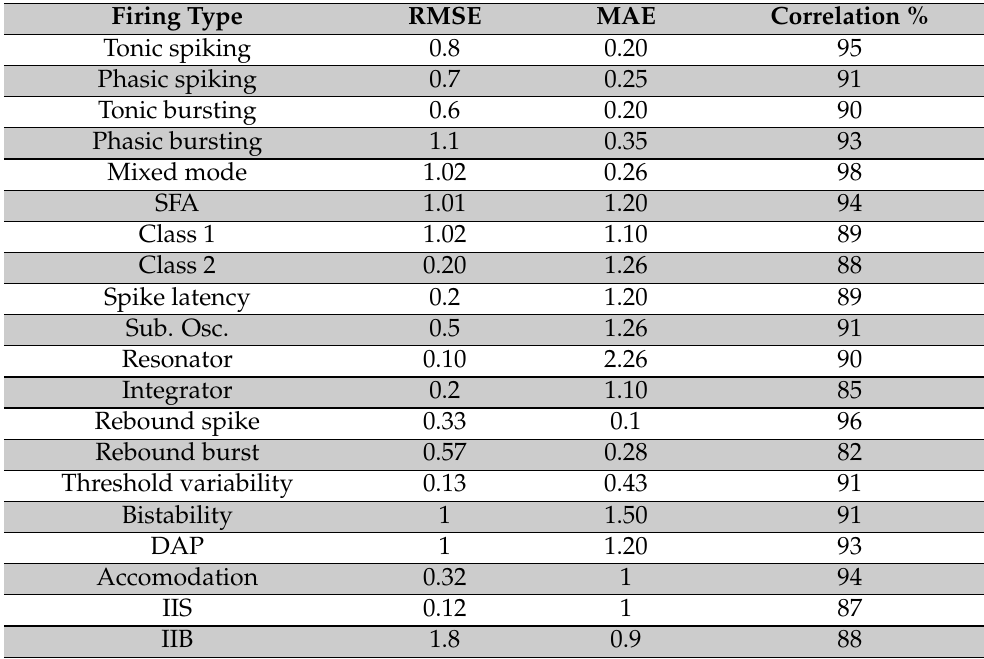
Figure 3. Different spiking patterns of the Izhikevich neuron model (original model with black line and the proposed model with green dotted line). ( a ) Tonic spiking pattern for the original and proposed neuron model. ( b ) Tonic bursting pattern for two models. ( c ) Mixed mode pattern for proposed and original modeling. ( d ) Spike frequency adaption. Table 3. RMSE, MAE, and Corr computations for different spiking